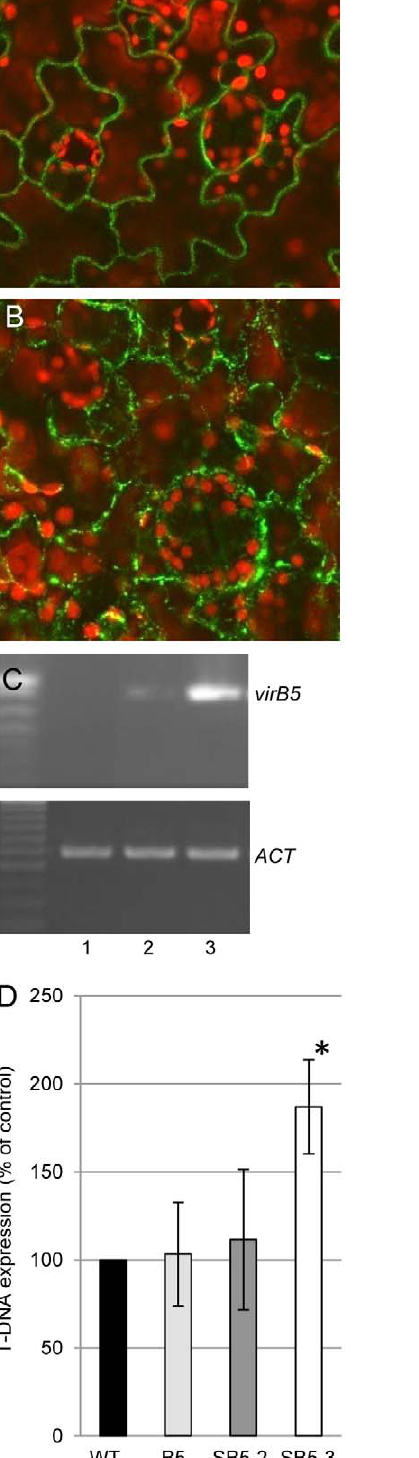
Figure 4. Effect of VirB5 secreted from transgenic plants on T- DNA expression. (A) Subcellular localization of GFP-secVirB5 in tobacco leaf cells. (B) Subcellular localization of GFP-secVirB5 in plasmolysed tobacco leaf cells. GFP is in green, plastid autofluorescence is in red. All images are single confocal sections. (C) RT-PCR analysis